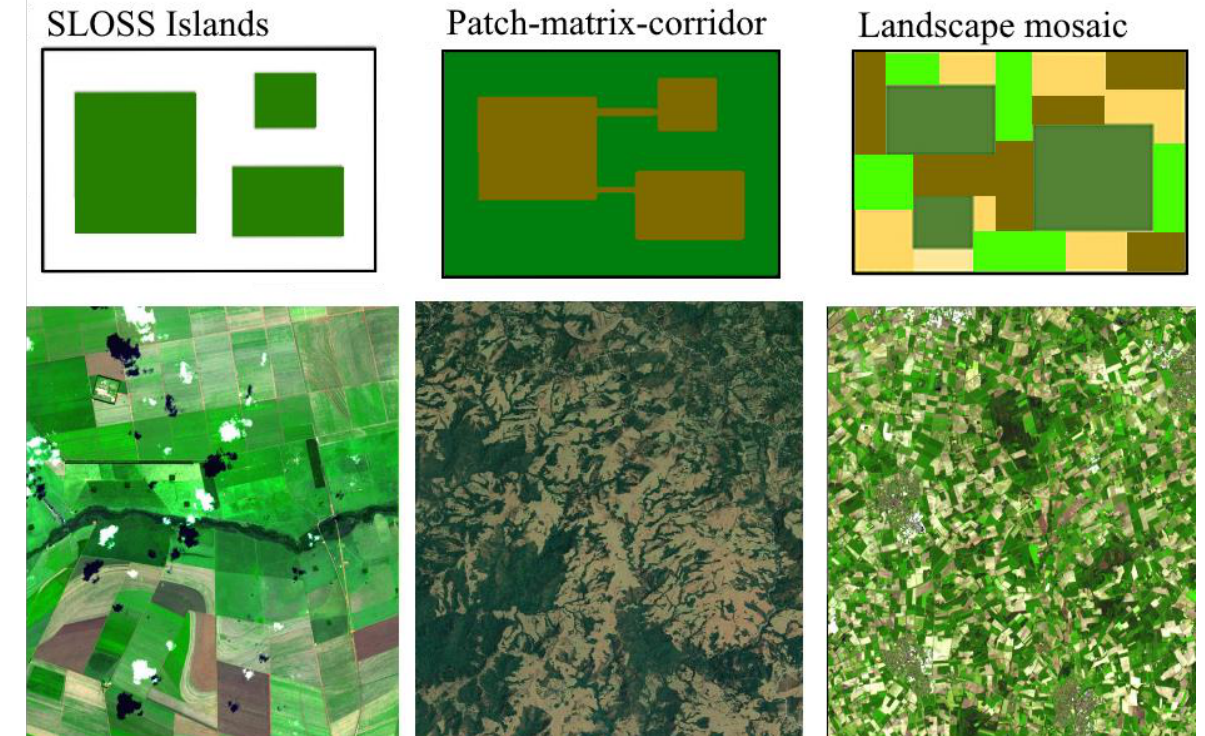
Figure 1. Conceptional landscape models of increasing multifunctionality (Left to Right) with associated aerial imagery from Brazil, Costa Rica, and Germany. Images 1 and 3 from NASA Earth Observatory, Image 2 from Google Earth.